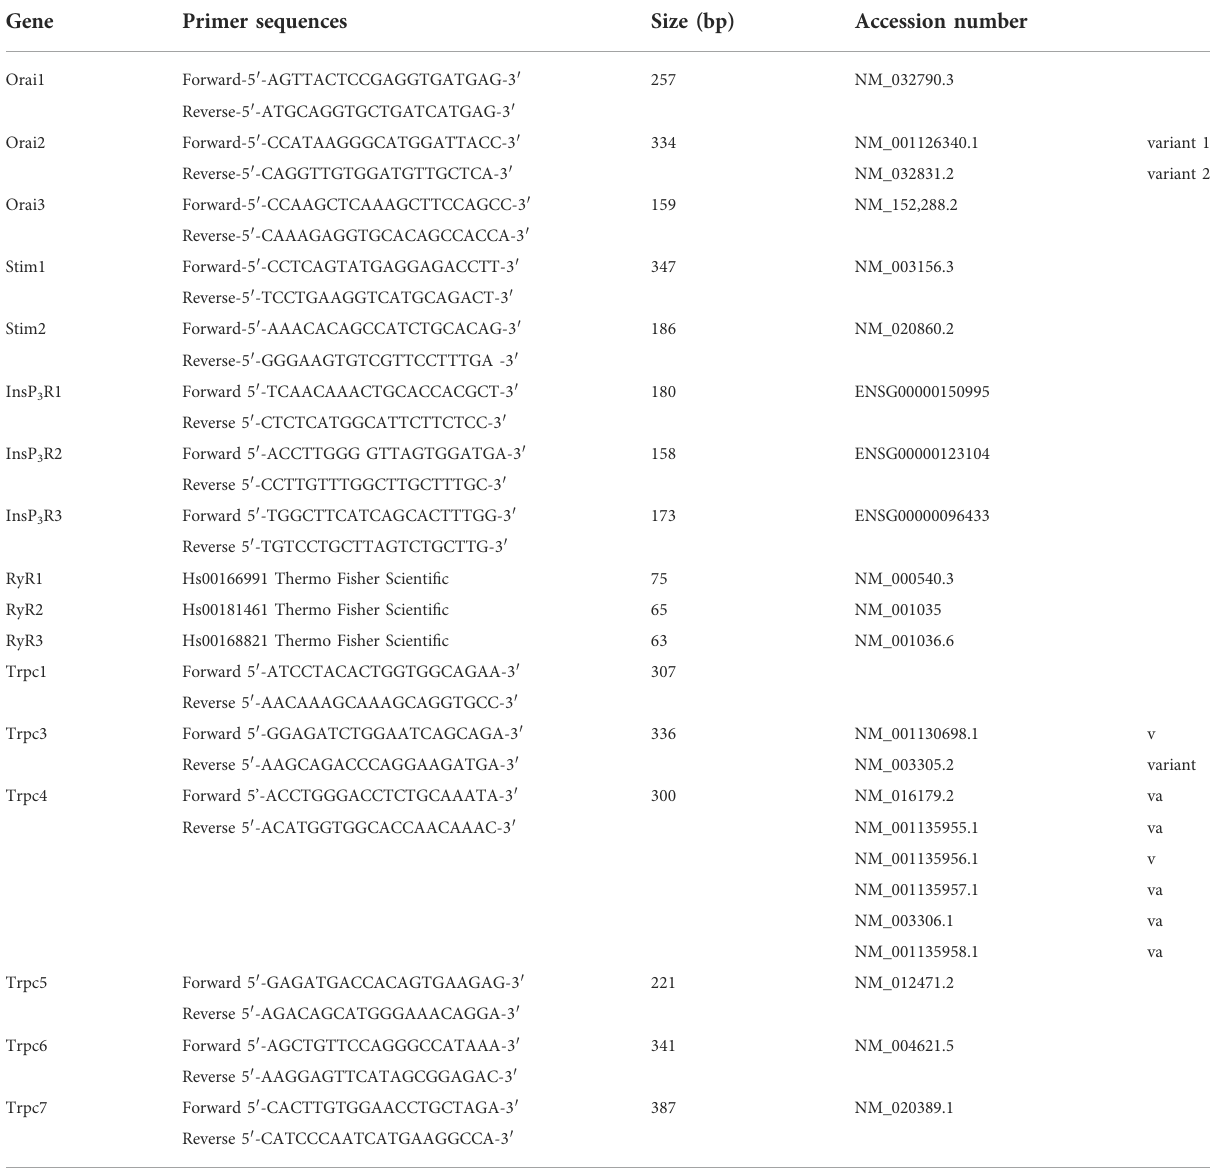
TABLE 1 Primer sequences used for reverse transcription/polymerase chain